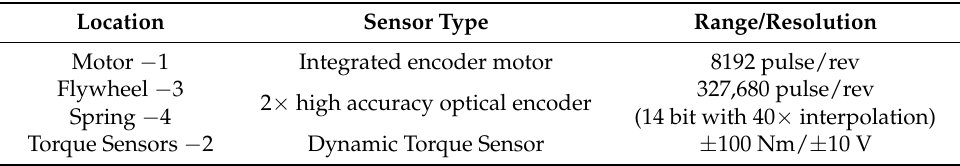
Table 3. Experimental setup sensor specifications.